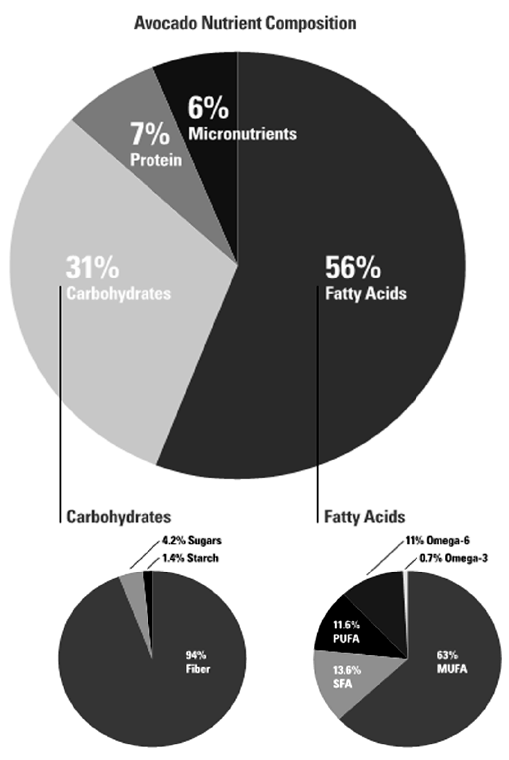
Figure 2. Avocado nutrient composition. Data sourced from: USDA Agricultural Research Service, National Nutrient Database for Standard Reference Release 27. Basic Report: 09038, Avocados, raw, California [7].